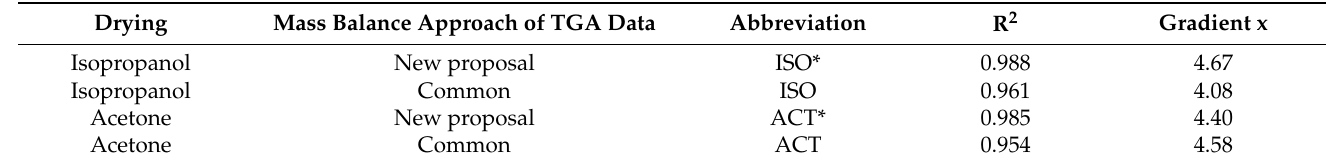
Table 3. Summary of the linear correlation of heat release = x · Consumption CH .